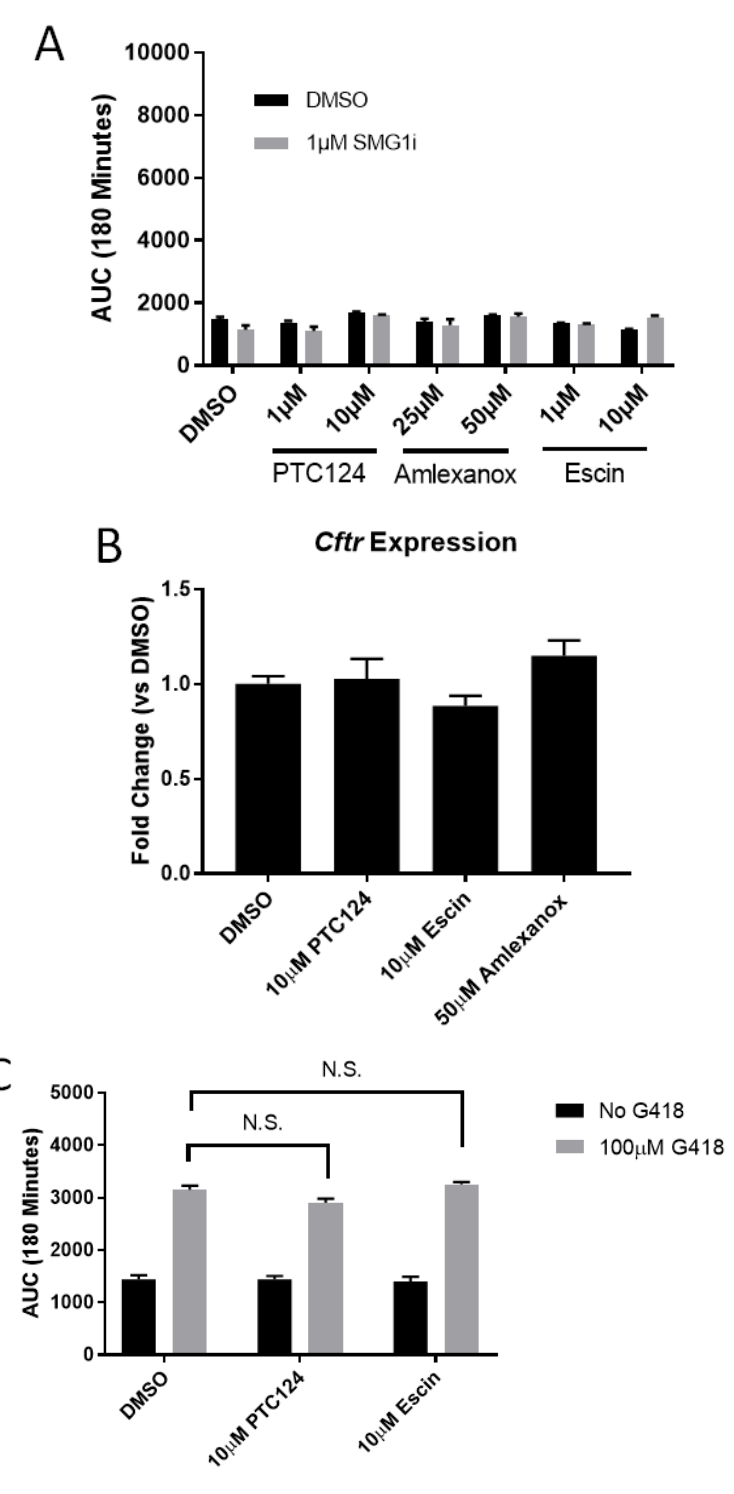
Figure 6. Non-aminoglycoside readthrough agents do not restore CFTR function in G542X intestinal organoids. ( A ). AUC measurements from G542X intestinal organoids treated with the indicated doses of PTC124, amlexanox, and escin with or without SMG1i. n = 3. ( B ). Cftr expression displayed as fold change vs. DMSO after 24 h incubation with the indicated com-pounds. ( C ). AUC measurements from intestinal organoids incubated for 24 h with the in-dicated compounds. n = 3–6 wells, analyzed using two way ANOVA with post-hoc Tukey test. All G418-treated groups are significantly increased over no G418 groups.